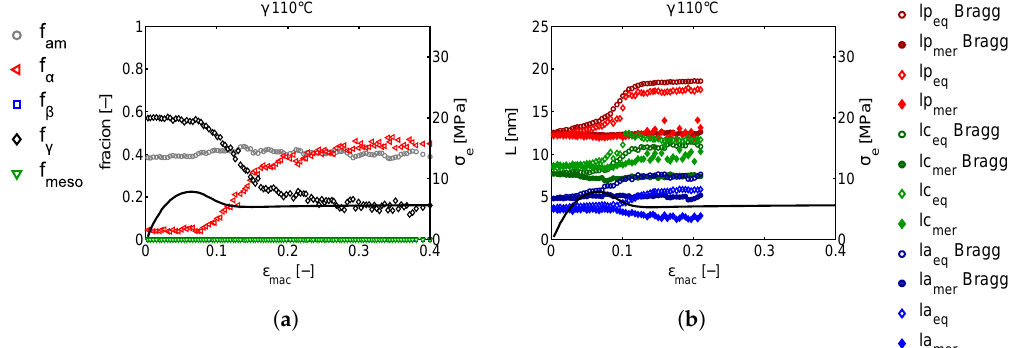
Figure 28. ( a ) Crystal phases in γ -iPP upon stretching at 110 ◦ C; and ( b ), The evolution of the long period, lamellar thickness, and amorphous layer